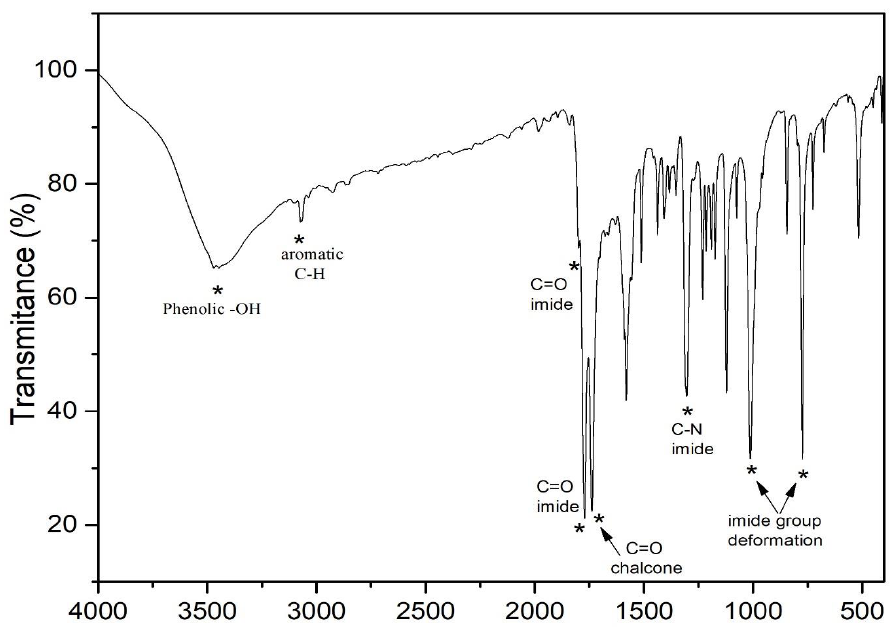
Figure 1. FTIR spectrum of phthalimide pendent novolac 5a .